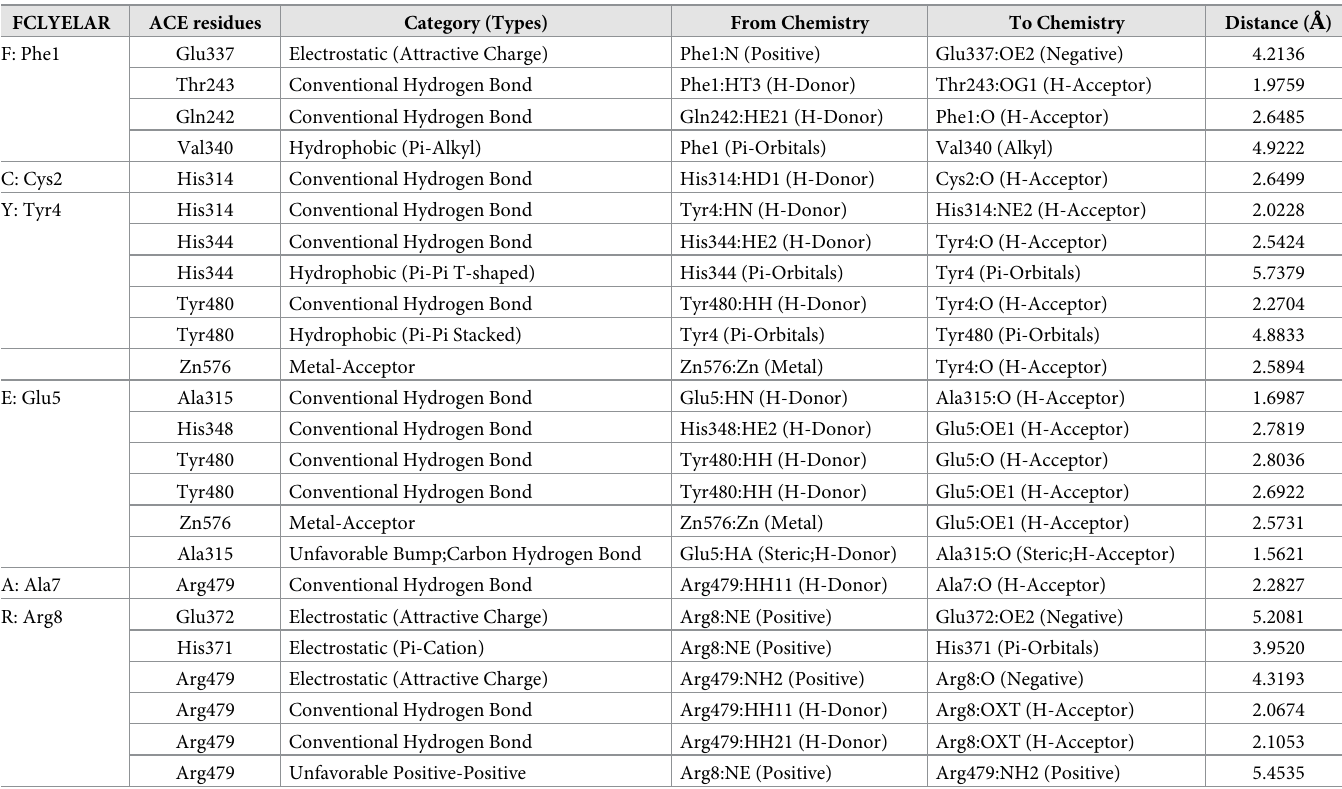
Table 9. Interactions between the ACE residues and the FCLYELAR peptide.